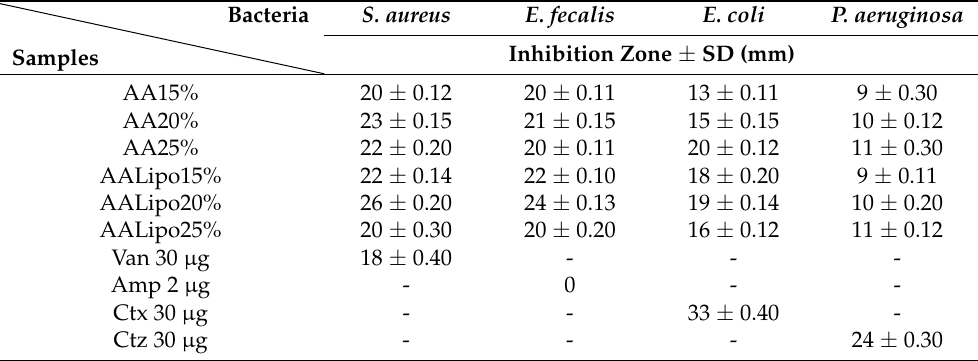
Table 2. Antimicrobial activity of AA and AALipo formulations against gram (+) ( Staphylococcus aureus and Enterococcus faecalis ) and gram ( − ) strains ( Escherichia coli and Pseudomonas aeruginosa ) expressed as diameter of inhibition